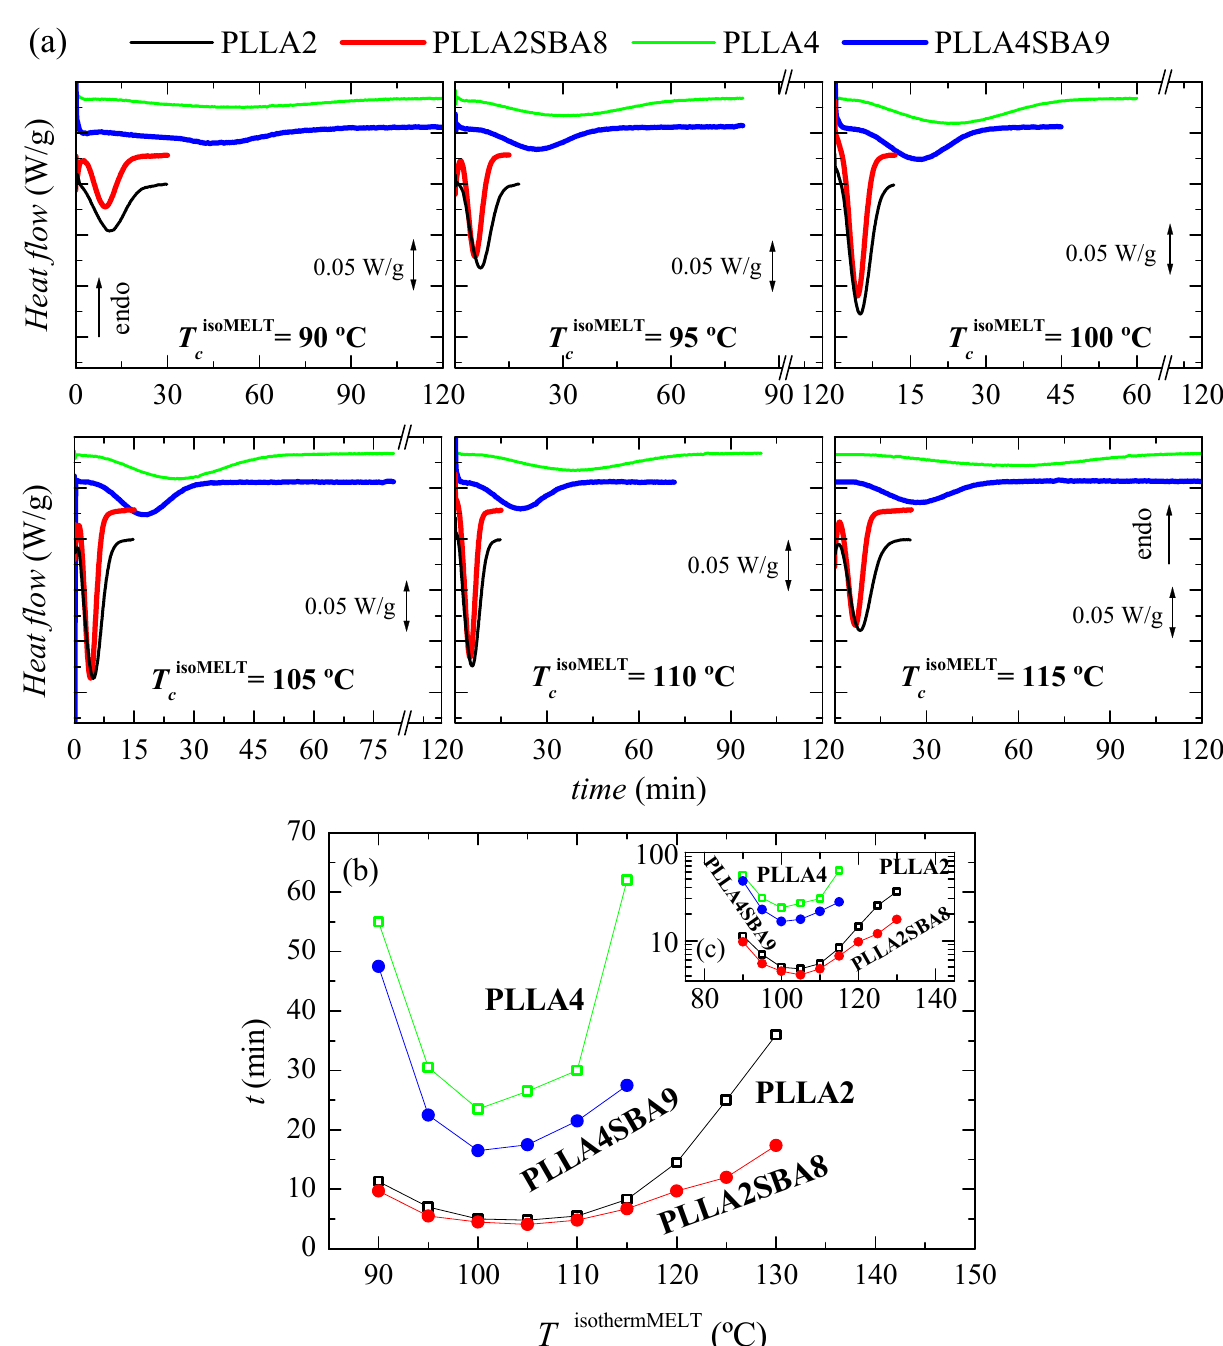
Figure 4. ( a ) Variation with time of heat flow for isothermal crystallization from the melt, T c isothermMELT , at different temperatures for PLLA2, PLLA2SBA8, PLLA4, and PLLA4SBA9. ( b ) De- pendence of time for peak crystallization with the T c isothermMELT in the PLLAs and their composites. ( c ) Time is represented in the logarithmic scale as a function of T c isothermMELT